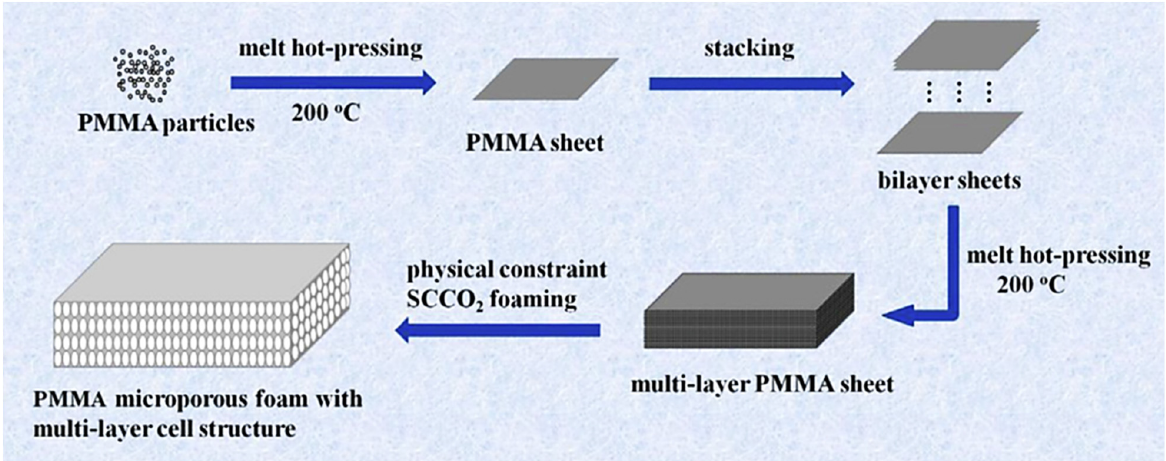
Figure 2. Schematic diagram of preparing PMMA microporous foam with multi-layer cell structure [47]. SCCO 2 = supercritical carbon dioxide. Reproduced with permission from Elsevier.